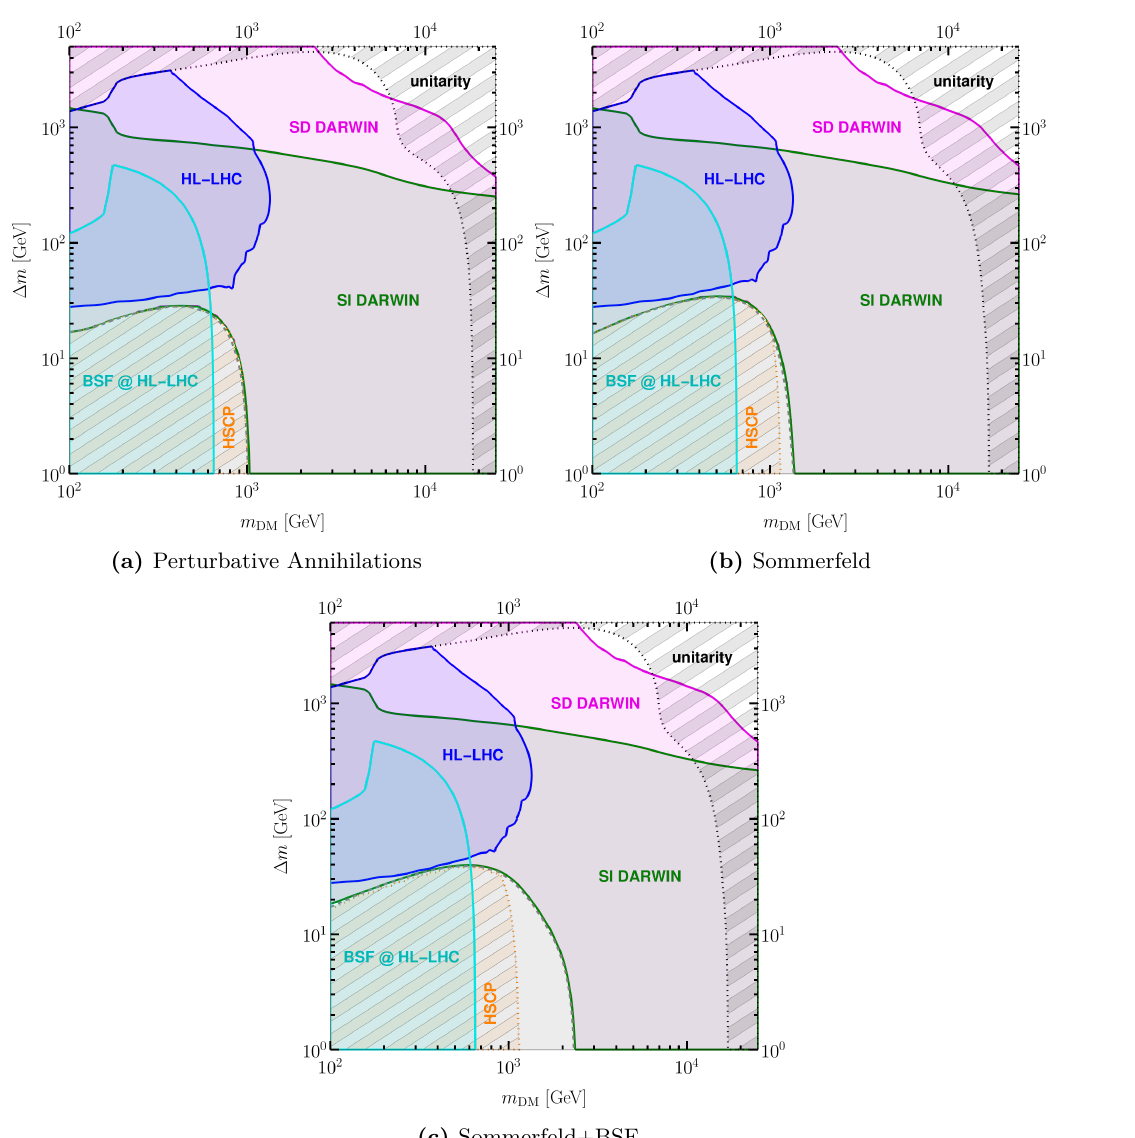
Figure 12. Projected exclusion limits from various future experiments on the u R -version of the model in the ( m ∆ m ) -plane. For each point in the plane, we determine the smallest value of DM , g DM such that DM is not overproduced. If this lower bound on g DM contradicts the projected limits from spin-independent DD (spin-dependent DD, prompt-collider searches, perturbative unitarity, stoponium searches, LLP searches), it is colored in green (magenta, blue, black, cyan, orange). We show the experimental limits obtained considering perturbative annihilations, the SE and the SE+BSF. The gray dashed line divides the parameter space into two regions. Above, the observed relic density can be generated via thermal freeze-out. Below, thermal freeze-out under-produces DM and accounting for the complete DM relic density requires production via conversion-driven freeze-out or